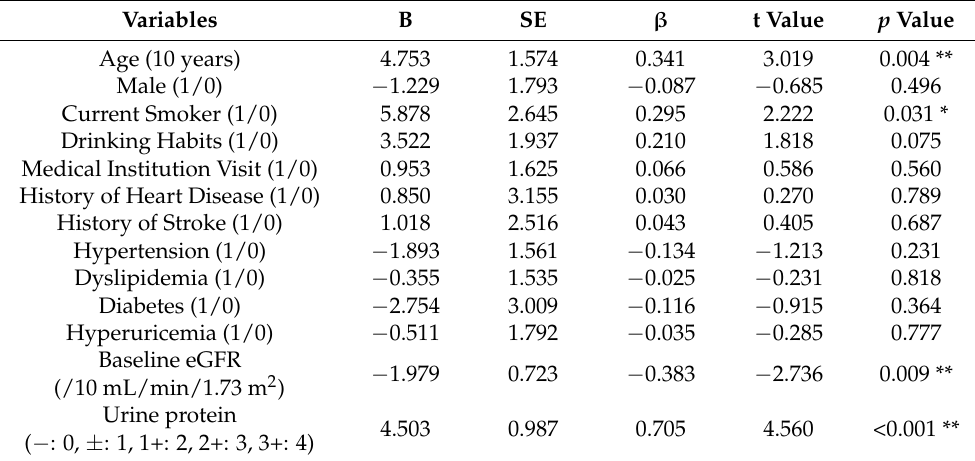
Table 3. Multivariate linear regression for factors influencing Δ eGFR. Variables